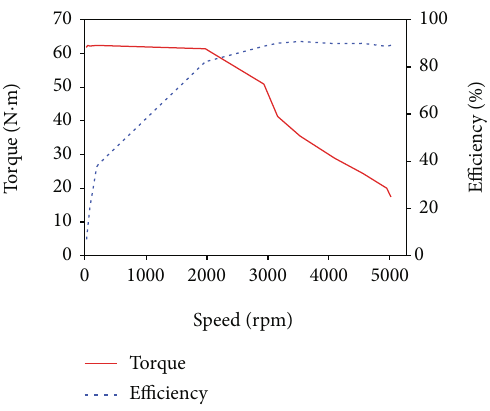
Figure 16: Motor characteristic